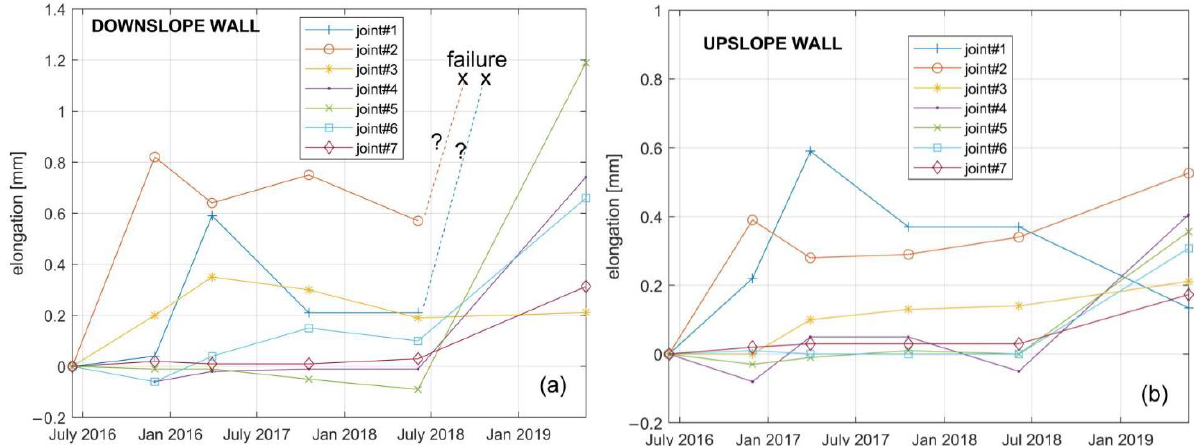
Figure 12. Elongation of the optical fiber computed based on the strains measured across the tunnel joints along the ( a ) downslope or ( b ) upslope sidewall. The symbol “?” indicates that measurements could not be taken due to fiber failure, while the symbol “x” denotes fiber failure (from Ref. [66]).